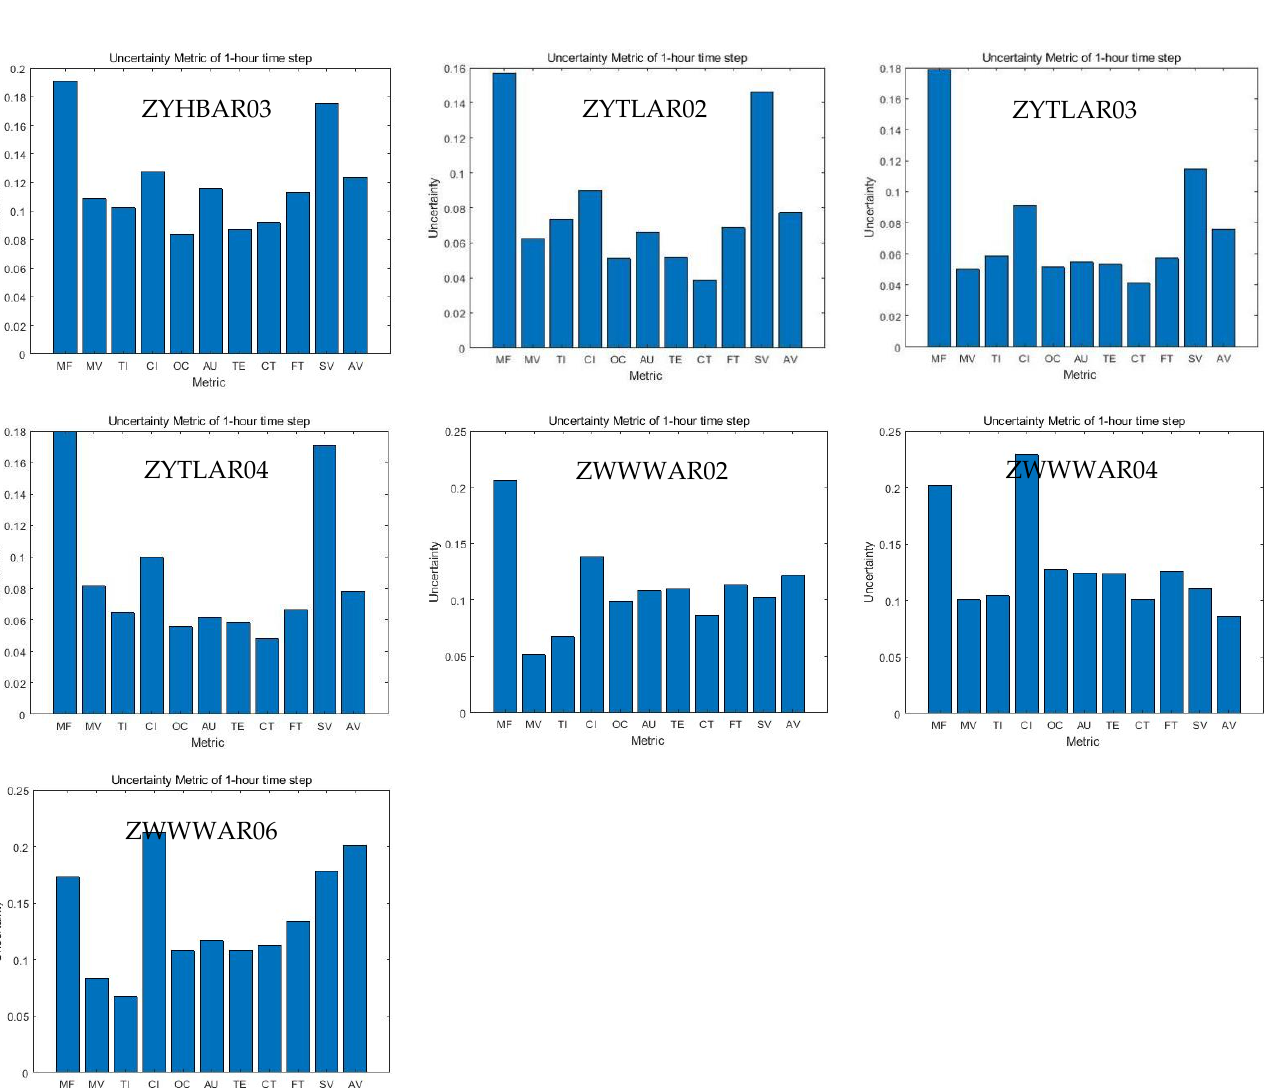
Figure A1. The uncertainty evaluation results of complexity indicators of 76 sectors in the China en-route airspace.